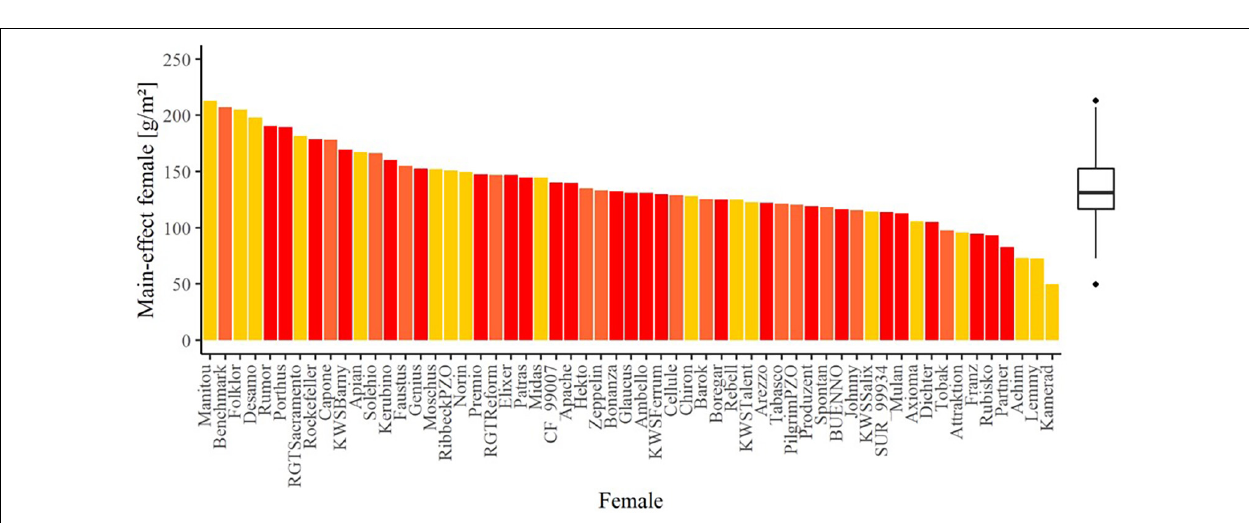
FIGURE 2 | The main effect of the female lines for the trait seed yield in the hybrid seed production experiment. The colors indicate the number of test years: dark red bars: three years, orange bars: 2 years, and yellow bars: 1 year. The boxplot shows the summary over all female